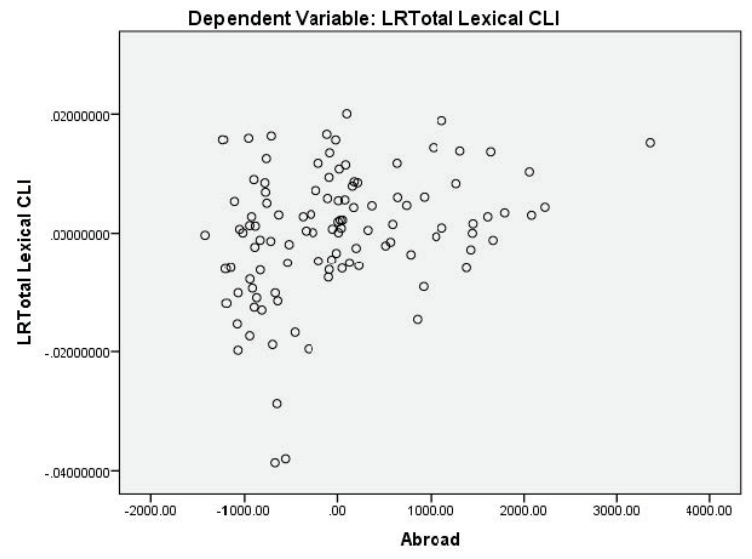
Figure 1. Scatterplot: Lexical CLI—Hours